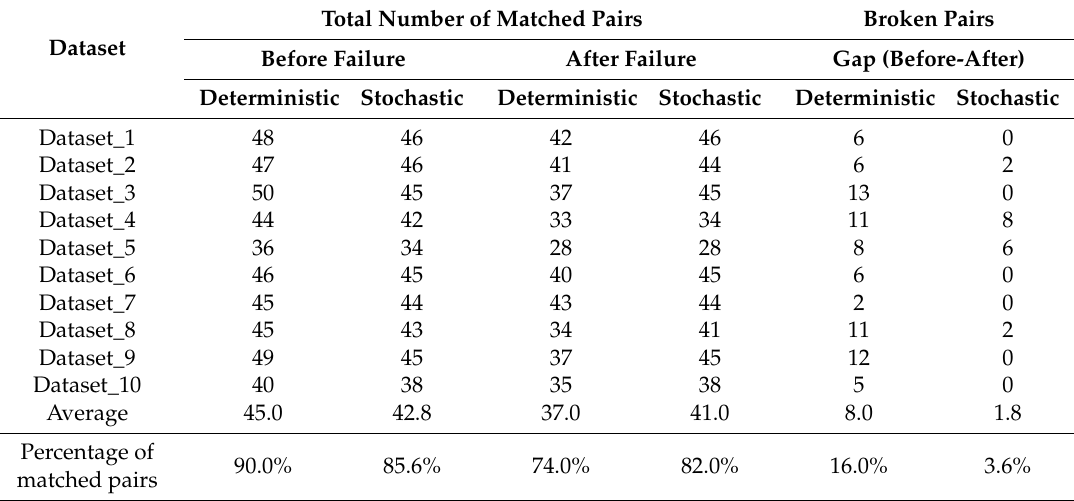
Table 6. Comparison of the number of unmatched pairs when a pair changes their